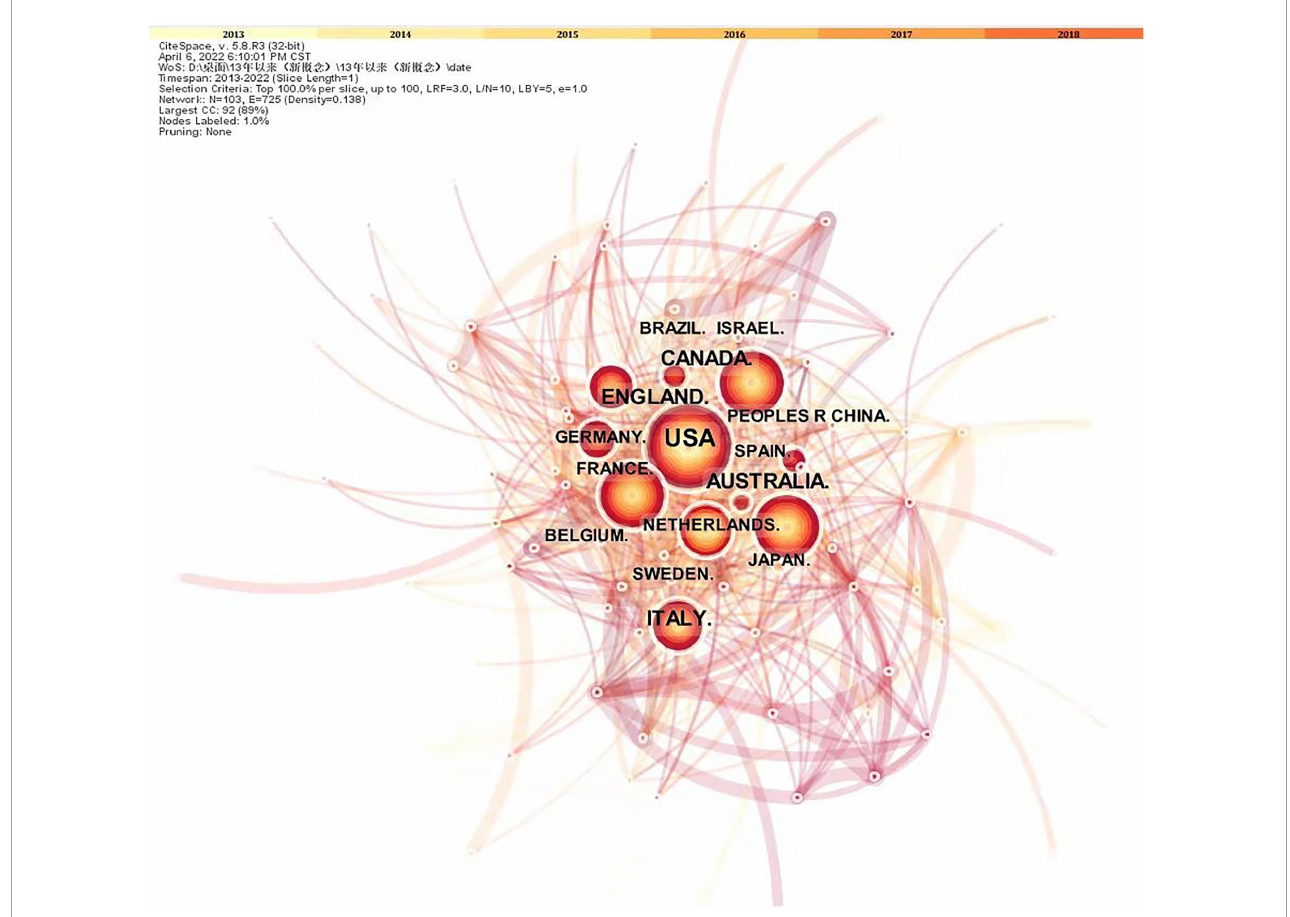
FIGURE3 Research papers published on state relations. The nodes in the graph are countries; the larger the node, the higher the volume of articles issued; and the connecting lines indicate the cooperation between countries; the more connecting lines, the better the communication ability of the nodes.